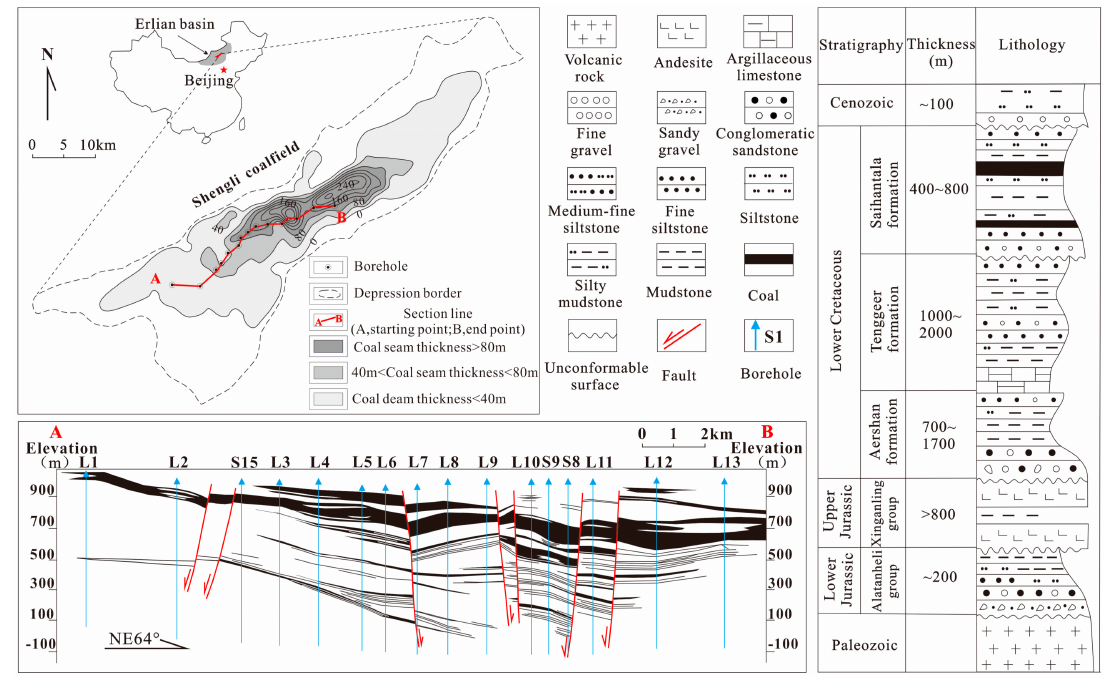
Figure 1. Location of the representative cross-section and stratigraphic column (modified from [29]). Reproduced with permission from Wang et al.; published by